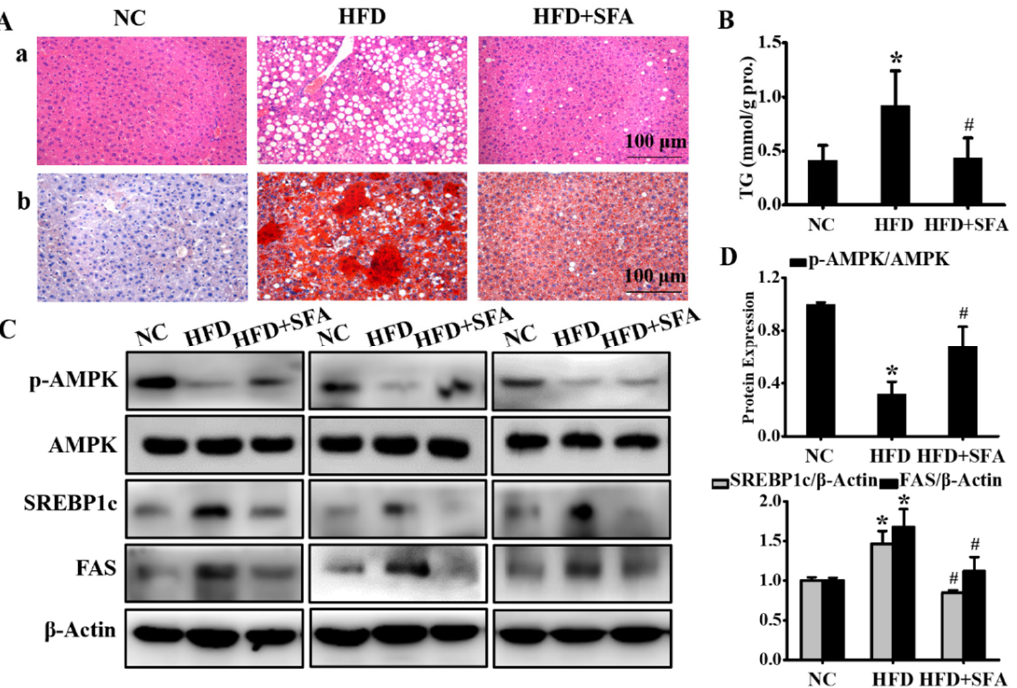
Figure 5. Evaluation of hepatic steatosis after SFA treatment to HFD-fed C57BL/6J mice: ( A ) histolog- ical images of liver sections by H&E ( a ) and Oil red O ( b ) staining. ( n = 5/group); ( B ) determination of TG levels in liver. ( n = 5/group); ( C ) Western blot analysis showed the expressions of phosphorylated AMPK, total AMPK, SREBP1c, and FAS in liver; ( D ) gray analysis of each band ( n = 3/group). All values are expressed as means ± SD, * p < 0.05 vs. NC group; # p < 0.05 vs. HFD group.